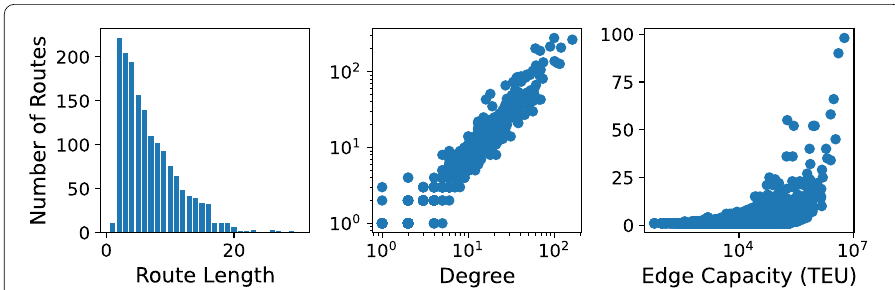
Figure 2 Statistics of the shipping routes. The left plot shows a histogram of the length of routes in terms of the number of edges. Most routes have length less than 10, but some visit as many as 30 ports. The middle plot shows the degree of a node (horizontal axis) against the number of routes the node appears in (vertical axis). The degree of a node in the path graph correlates with the number of routes it participates in and most nodes appear in a few routes, while some appear in more than 200. The right plot shows the estimated edge capacity in TEU (horizontal) against the number of routes in which each edge appears. Most edges appear in only a handful of routes, while few appear in nearly 100, and TEU capacity spans multiple orders of magnitude and correlates with the number of routes in which a port appears